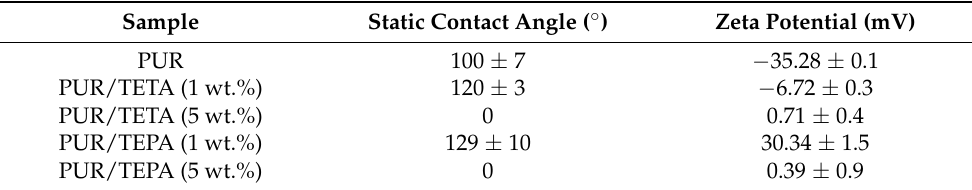
Table 2. Static contact angles and zeta potentials for all the membranes tested.